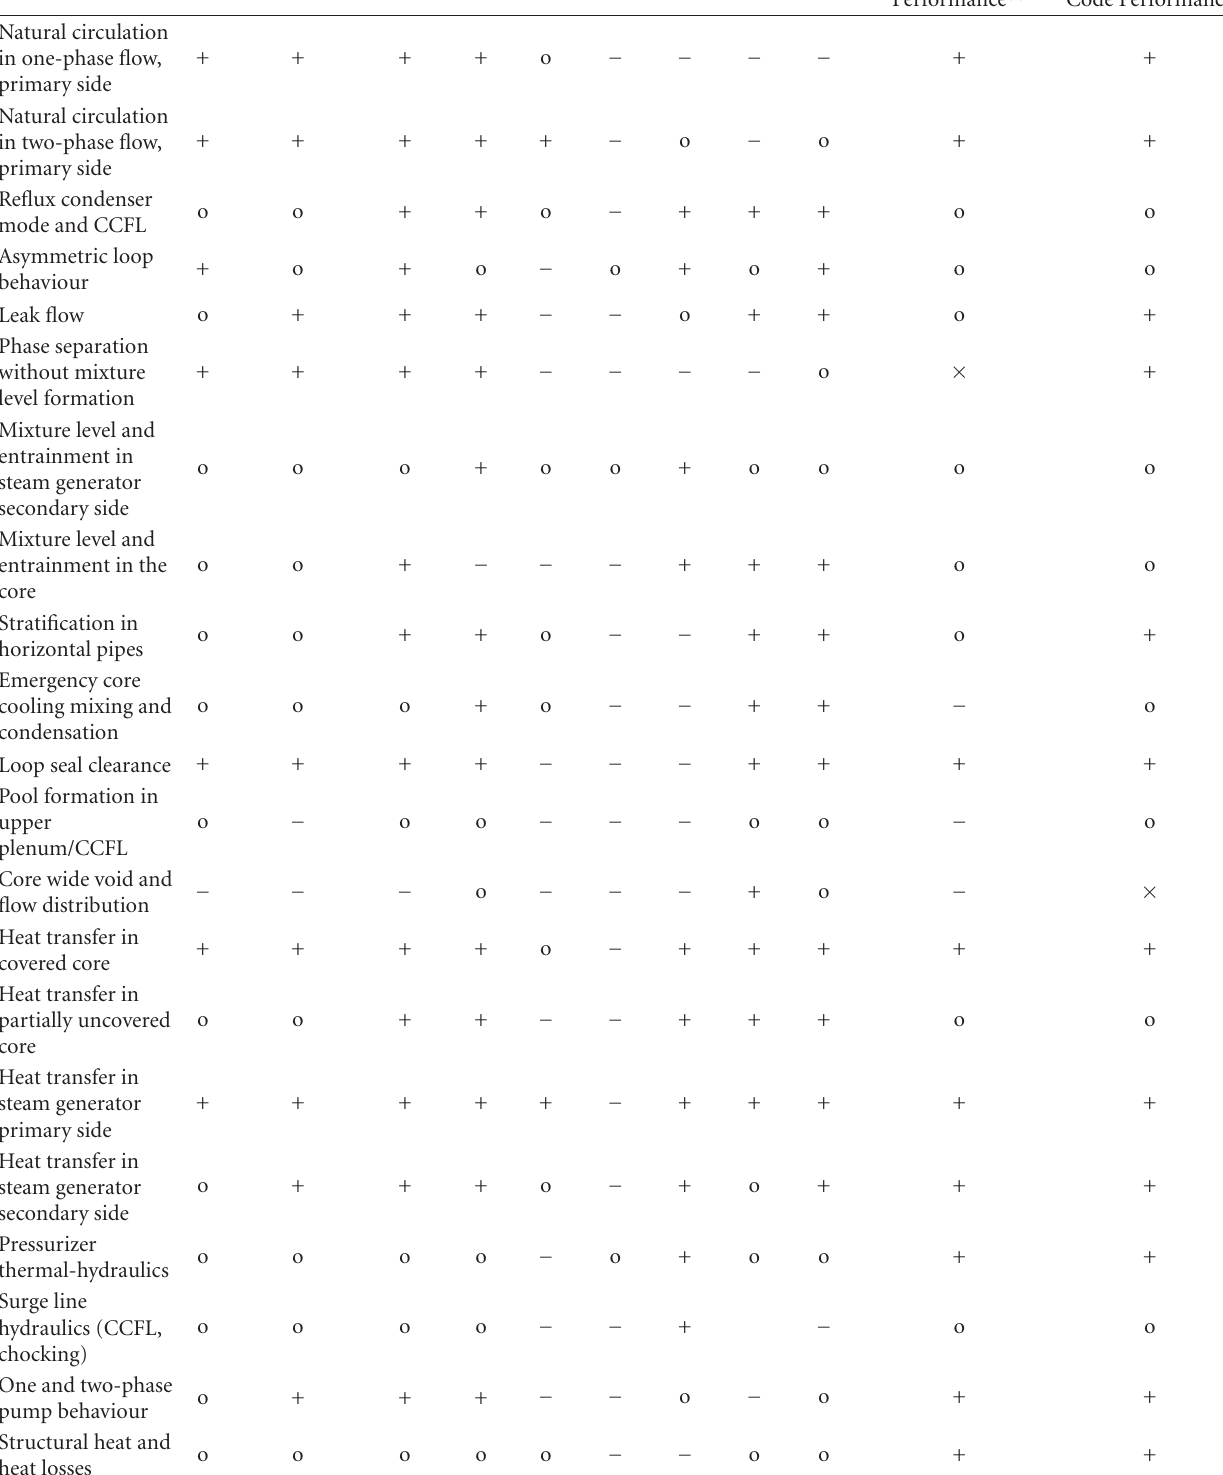
Table 5: Suitability of tests facilities, judgment of the experiments, and (example of) evaluation of RELAP5/Mod2 and CATHARE code capabilities as from